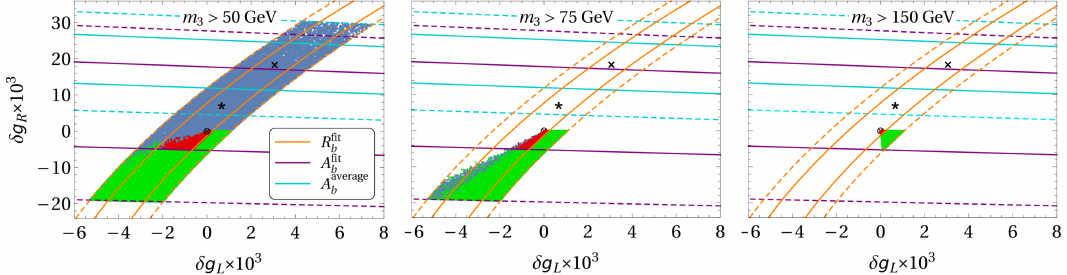
Figure 8 . Scatter plot of δg n colour code employed are the same as in figure 6. The dashed straight lines mark the condition = δg c and the dashed-dotted lines correspond to δg n δg n R R